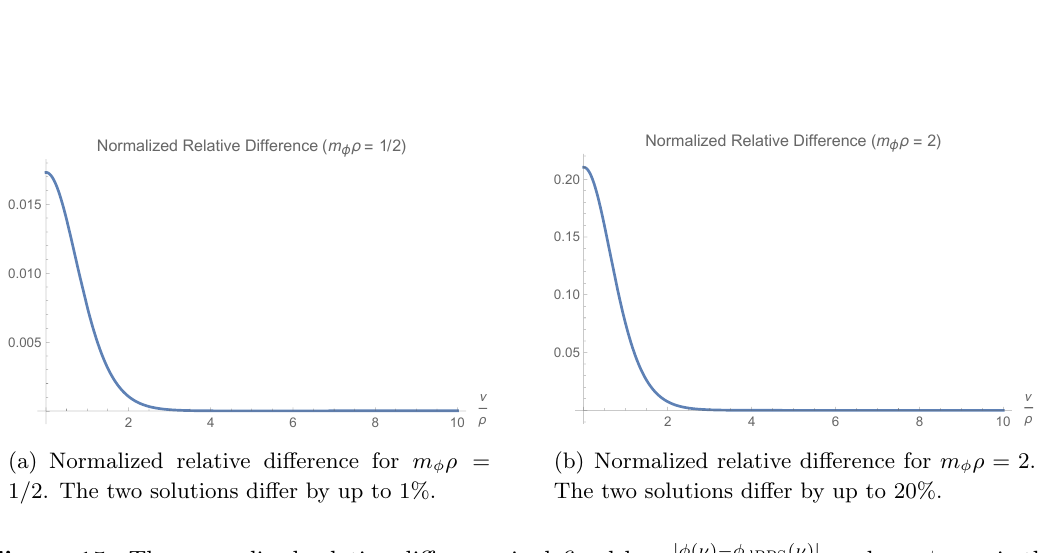
(a) Normalized relative di(cid:11)erence for m (cid:30) (cid:26) = 1 = 2. The two solutions di(cid:11)er by up to 1%. Figure 15 . The normalized relative di(cid:11)erence is de(cid:12)ned by j (cid:30) ( (cid:23) ) (cid:0) (cid:30) dBPS ( (cid:23) ) j exact double BPS solution. Numerical experiments in the m A then the numerical solution is well approximated by the exact double BPS solution. If m (cid:30) (cid:26) >